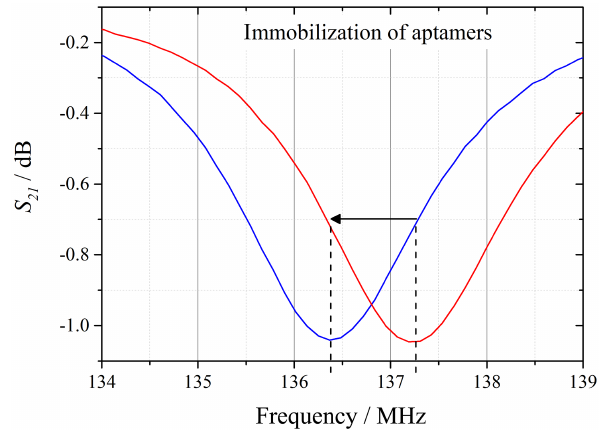
Figure 20. S 21 with deionized water as sample before and after immobilization of